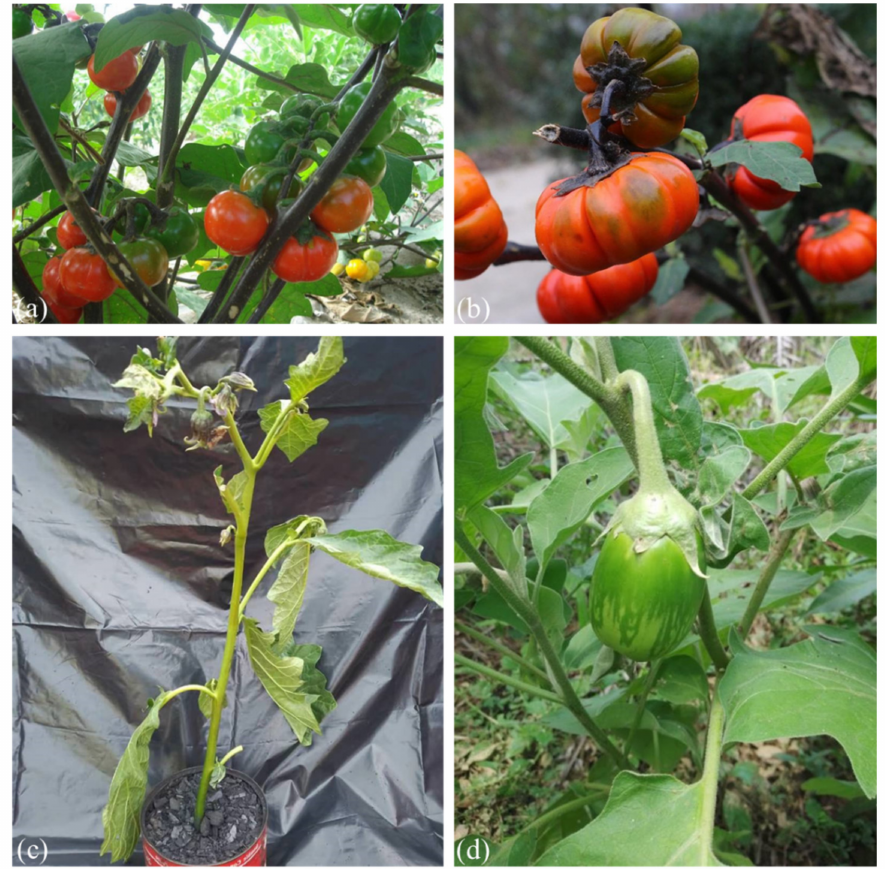
Figure 1. Fruit vegetable pictures for ( a ) Kumba, ( b ) Aculeatum, ( c ) Shum and ( d ) Gilo group of Solanum